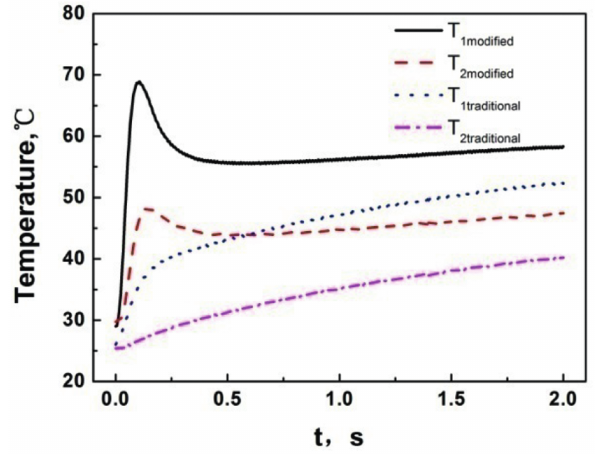
Figure 3: Temperature curves measured by traditional and modified methods.